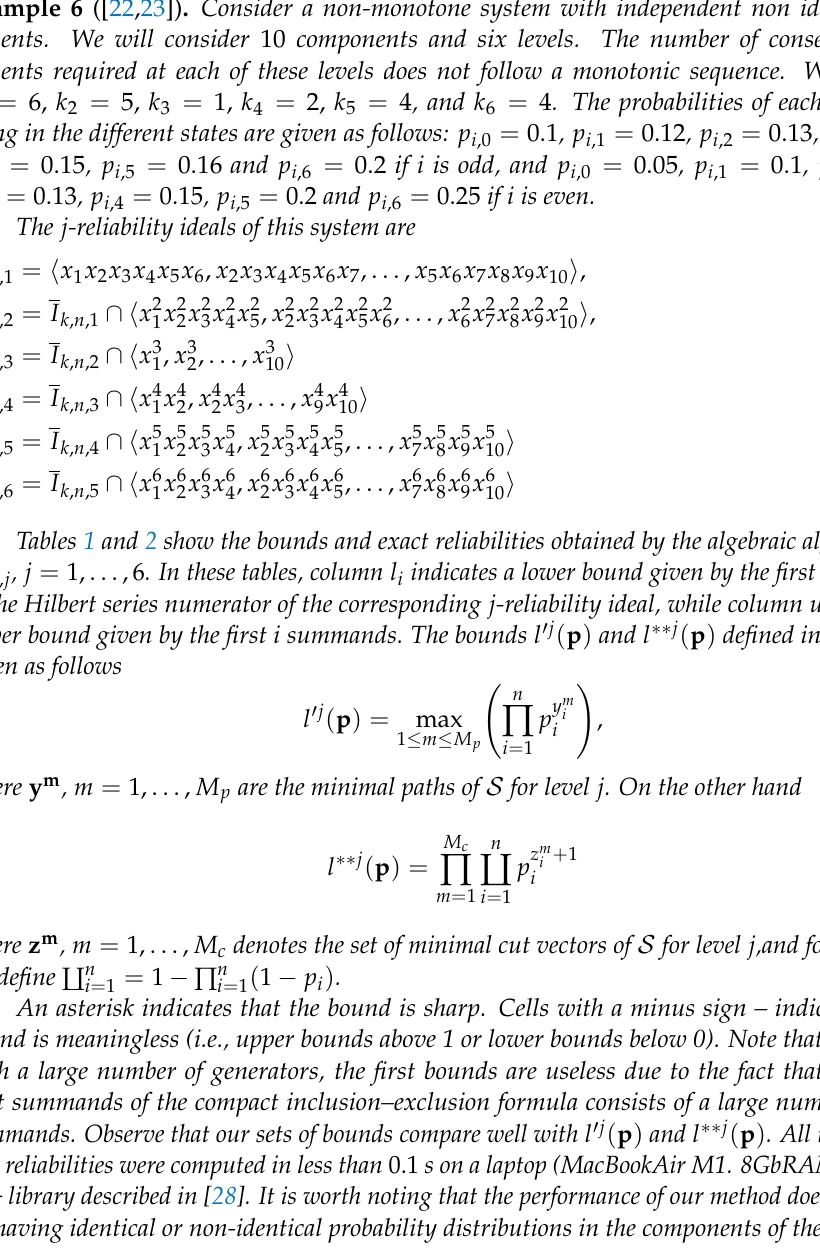
Table 1. Lower bounds for the j -reliability of the consecutive k -out-of- n system in Example 6. Level